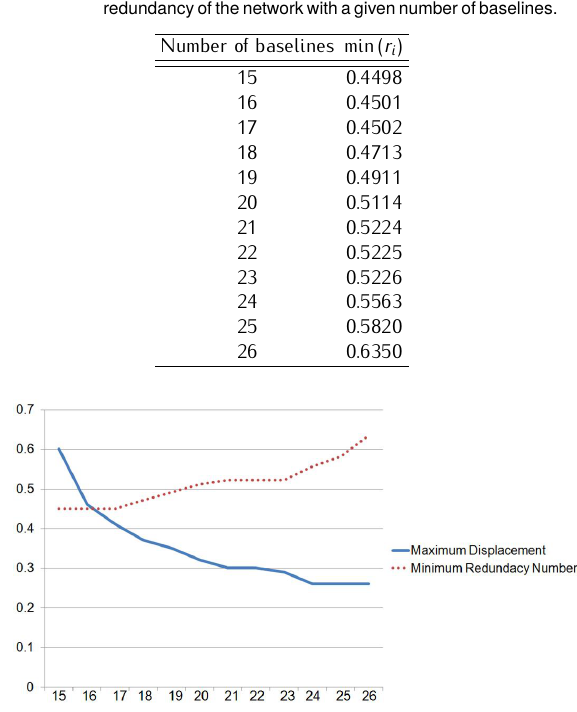
Table 4. Minimumredundancynumbersandthenumberofbaselines in the network. Minimum redundancy min ( r i )is the lowest redundancyofthenetworkwithagivennumberofbaselines.